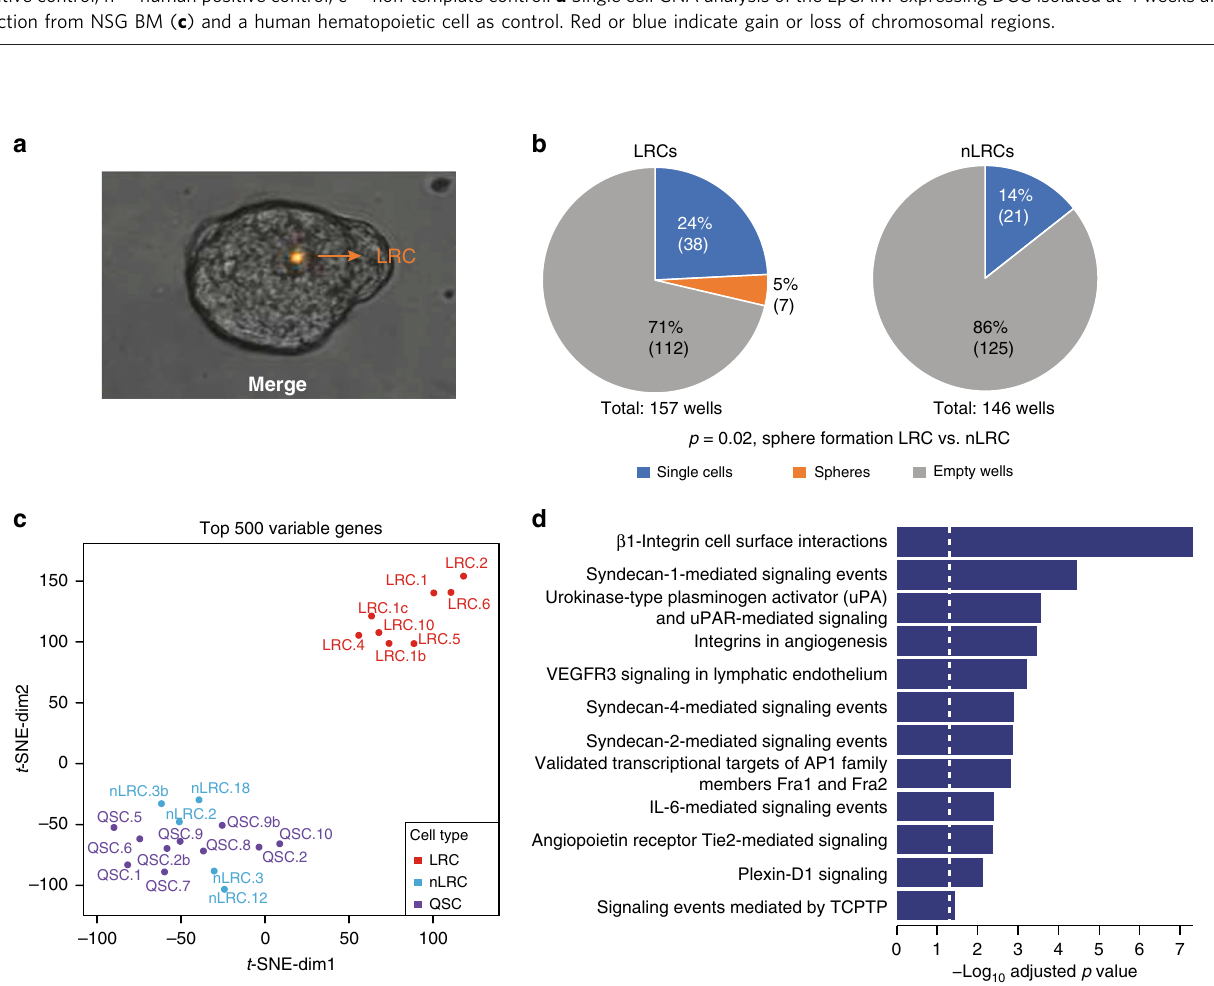
Fig. 1 Xenotransplantation of DCCs. a Diagnostic bone marrow aspirates from breast (BrCa, n = 19) or prostate (PC, n = 27) cancer patients (M0- or M1- stage of disease) were either CD45-depleted, enriched for EpCAM, or cultured under sphere conditions. Resulting spheres, CD45-depleted, or EpCAM- enriched BM cells were injected intra-venously (i.v.), intra-femorally (i.f.), sub-cutaneously (s.c.), sub-renally (s.r.), or into the mammary fat pad (mfp) of NOD-scid or NOD-scidIL2R γ -/- mice. Mice with sub-cutaneous or mammary fat pad injections were palpated weekly. All other mice were observed